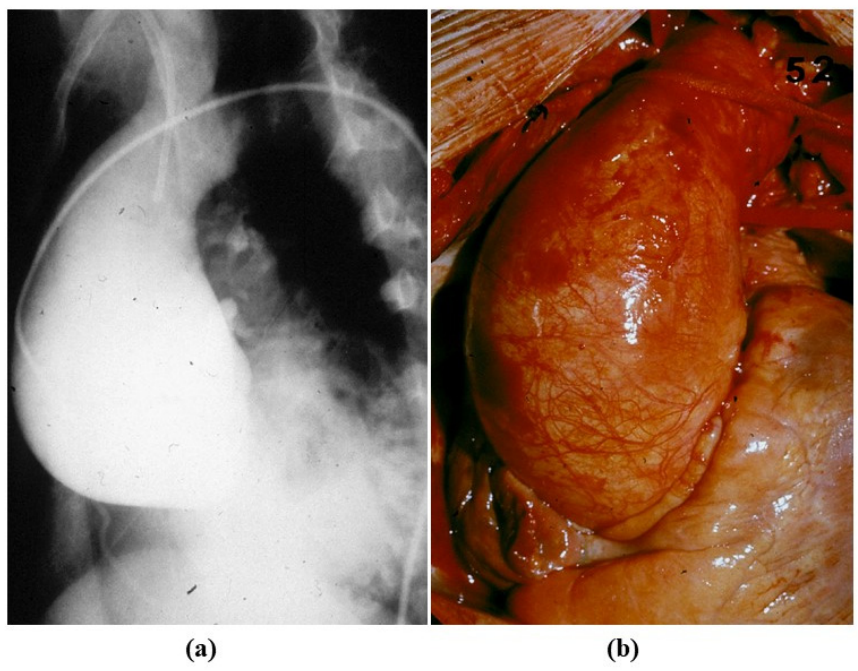
Figure 17. Angiographic ( a ) and intraoperative ( b ) gross views of non-inflammatory anuuloaortic ectasia with valve incompetence.